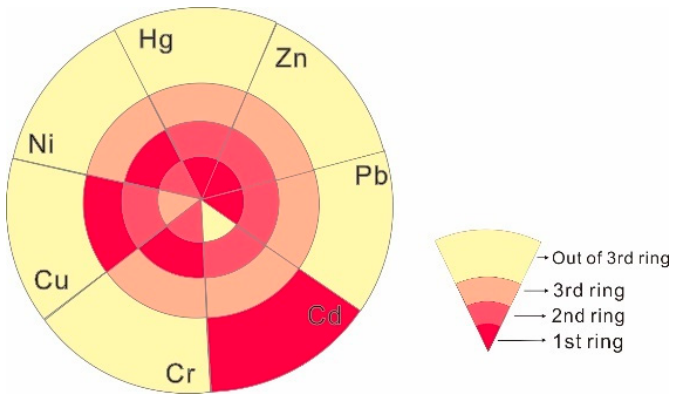
Figure 2. Distribution trend map for heavy metal concentration (darker = higher) in each Shijiazhuang ring.